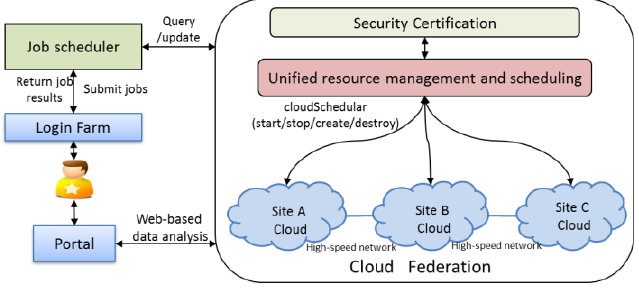
Figure 3. System architecture